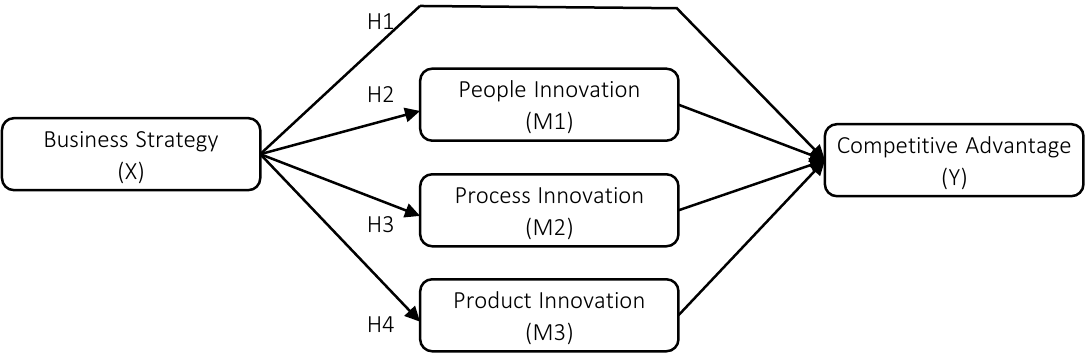
Figure 1. Conceptual framework